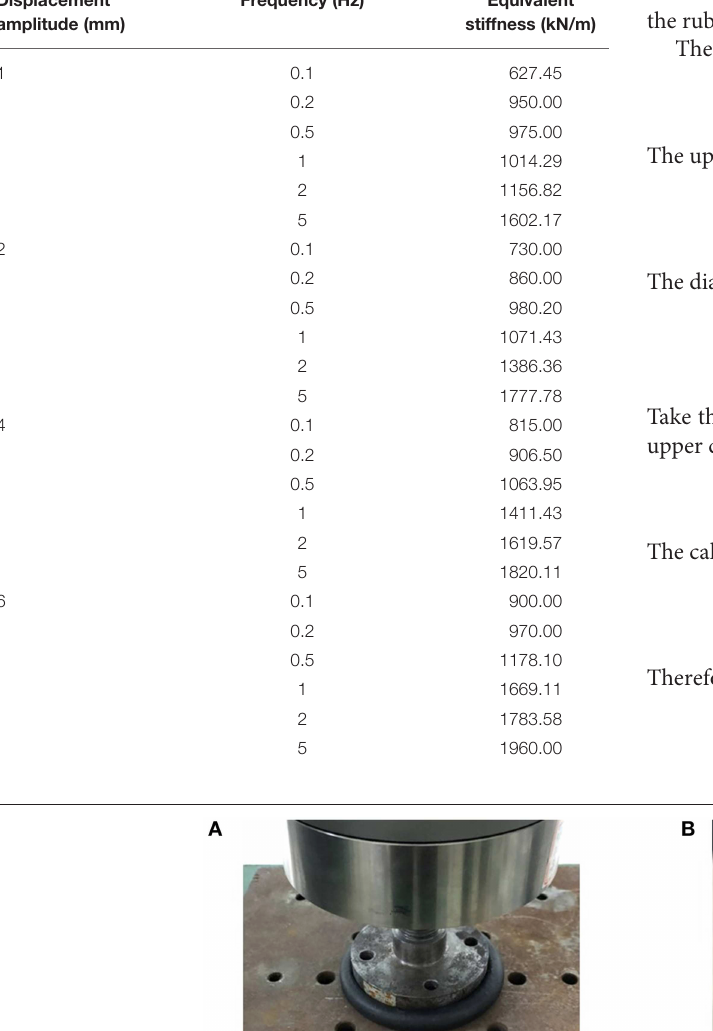
TABLE 2 | Same displacement amplitude equivalent stiffness as a function of frequency.